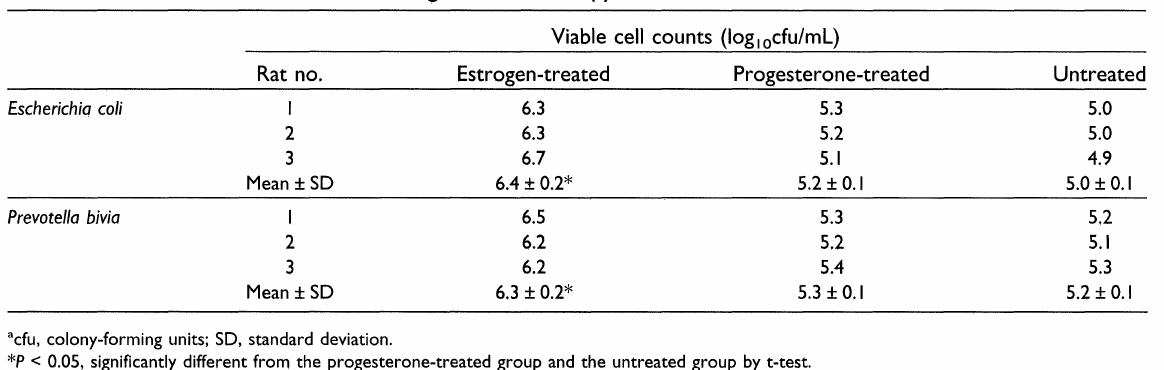
TABLE 3. Hormonal effects on bacterial growth in a rat pyometra model Viable cell counts (Iog0cfu/mL) Rat no. Estrogen-treated Progesterone-treated Untreated Escherichia